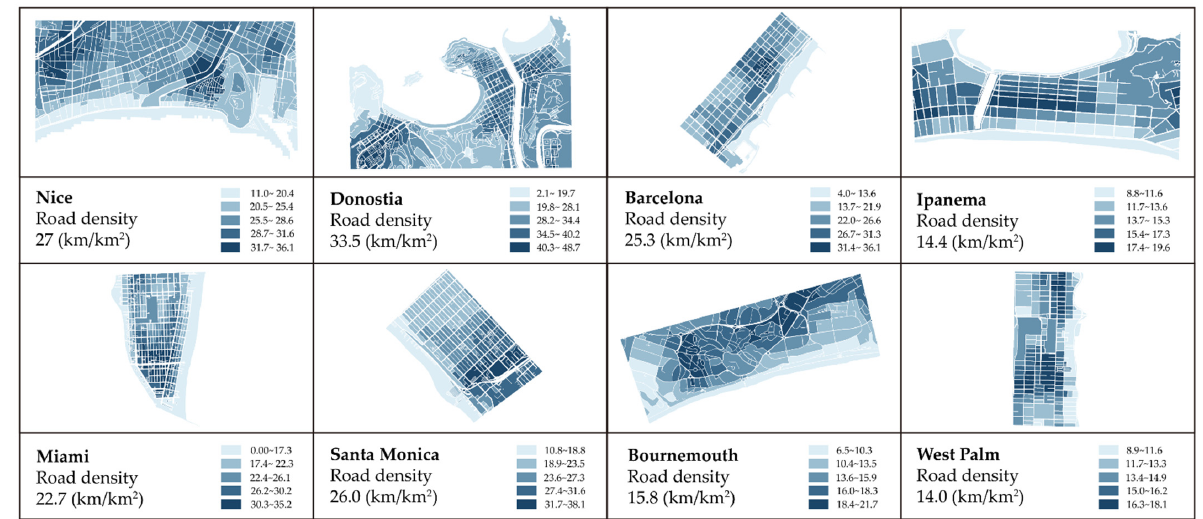
Figure 3. The visualization results of road density in successful coastal cases.